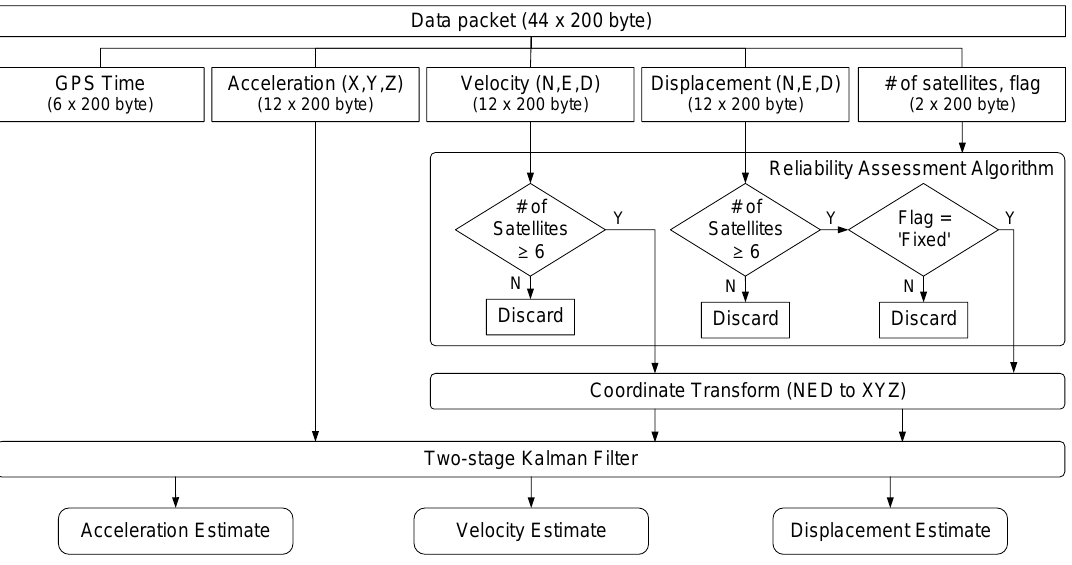
Figure 6. Data processing flowchart for dynamic response estimation at computation module.